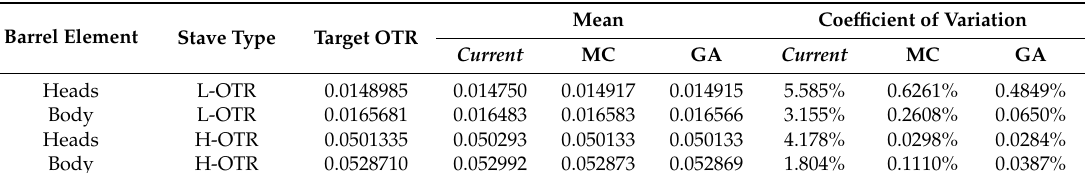
Table 4. Results of the construction of the heads and bodies for 50 low-OTR (L-OTR) or high-OTR (H-OTR) barrels.